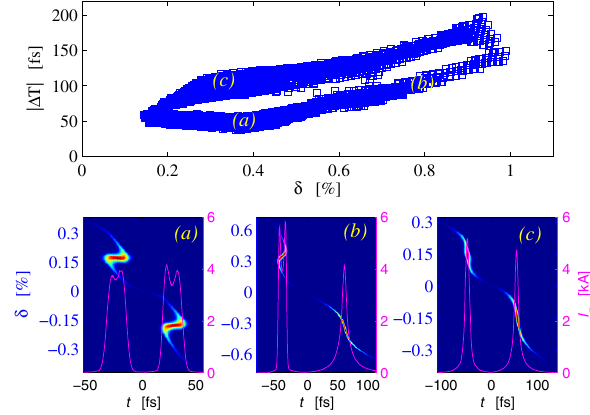
FIG. 6. Working points with peak current 3 – 5 kA of the core part of the beam (up) and three typical longitudinal phase spaces with current profiles (down) of the twin bunches at the exit of L3, which are labeled ð a Þ ; ð b Þ ; ð c Þ respectively.